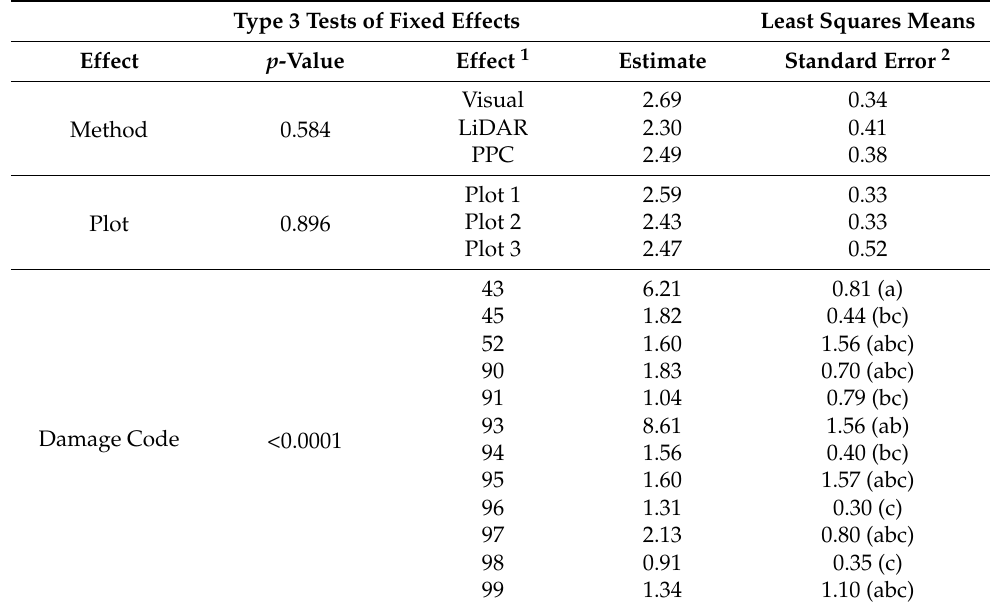
Table 6. Mean damage length (m) per tree comparing visual inventory, handheld LiDAR, and PPC-based methods of assessing tree